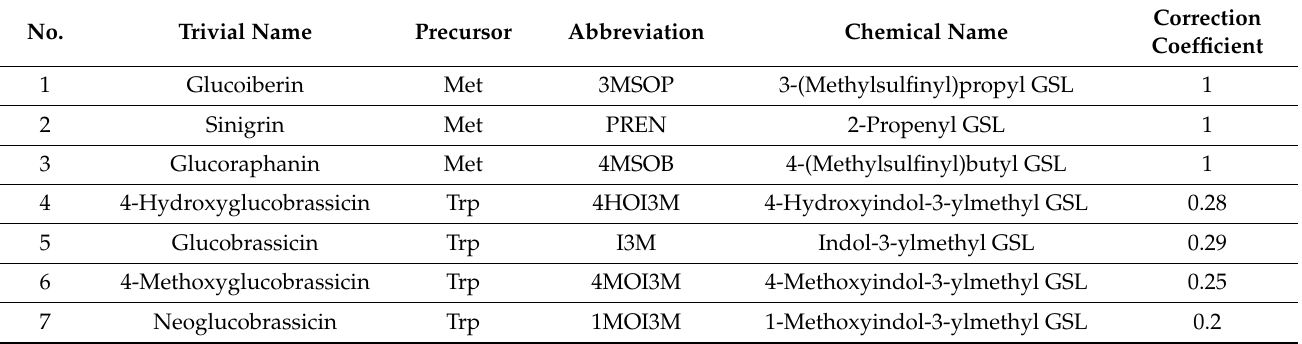
Table 1. Nomenclature of the GSLs identified in broccoli leaves and